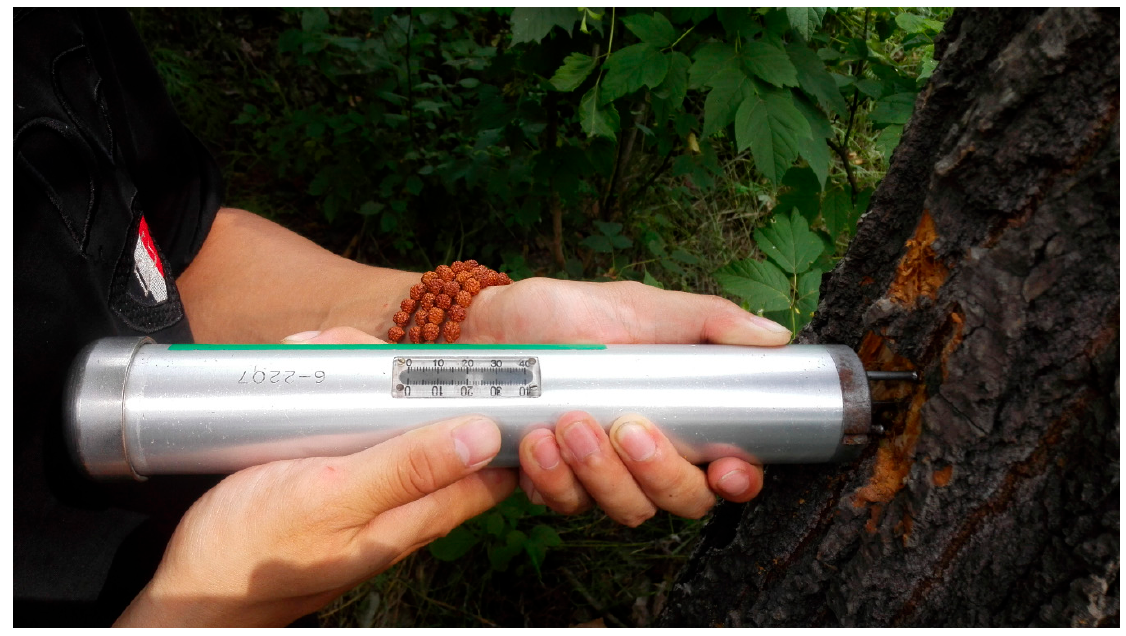
Figure 3. The Pilodyn wood tester (photo credit: Shan Gao).